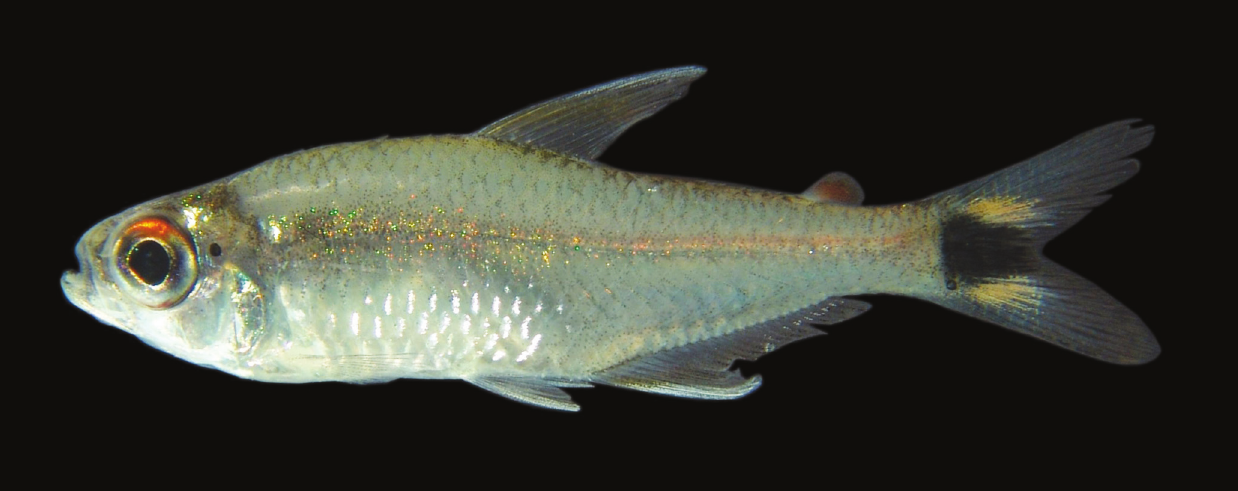
Fig. 4. Astyanax multidens , photographed live, MZUSP 91955, ca . 25 mm SL, rio Culuene, tributary of rio Xingu (photo by Leandro